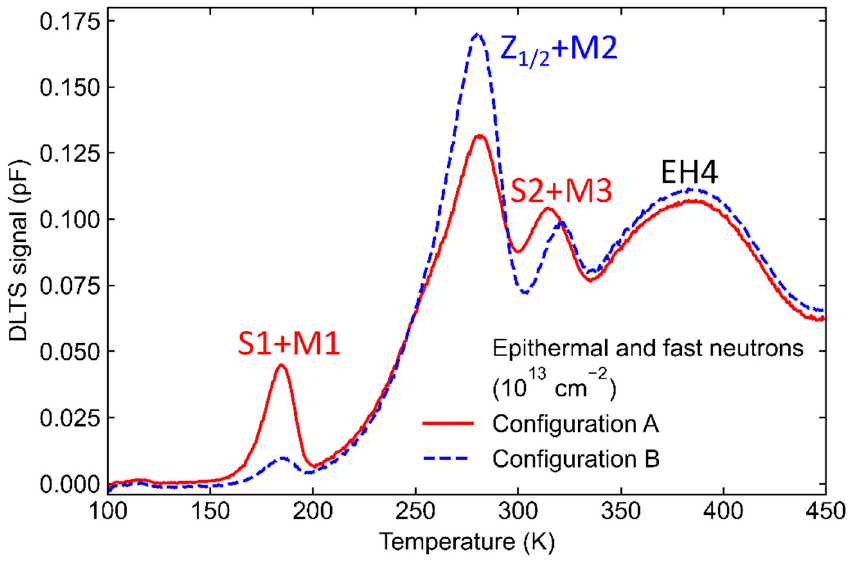
Figure 3. DLTS spectra of neutron-irradiated 4H-SiC samples in two configurations of the M-center, configuration A (red, solid) and configuration B (blue, dashed).